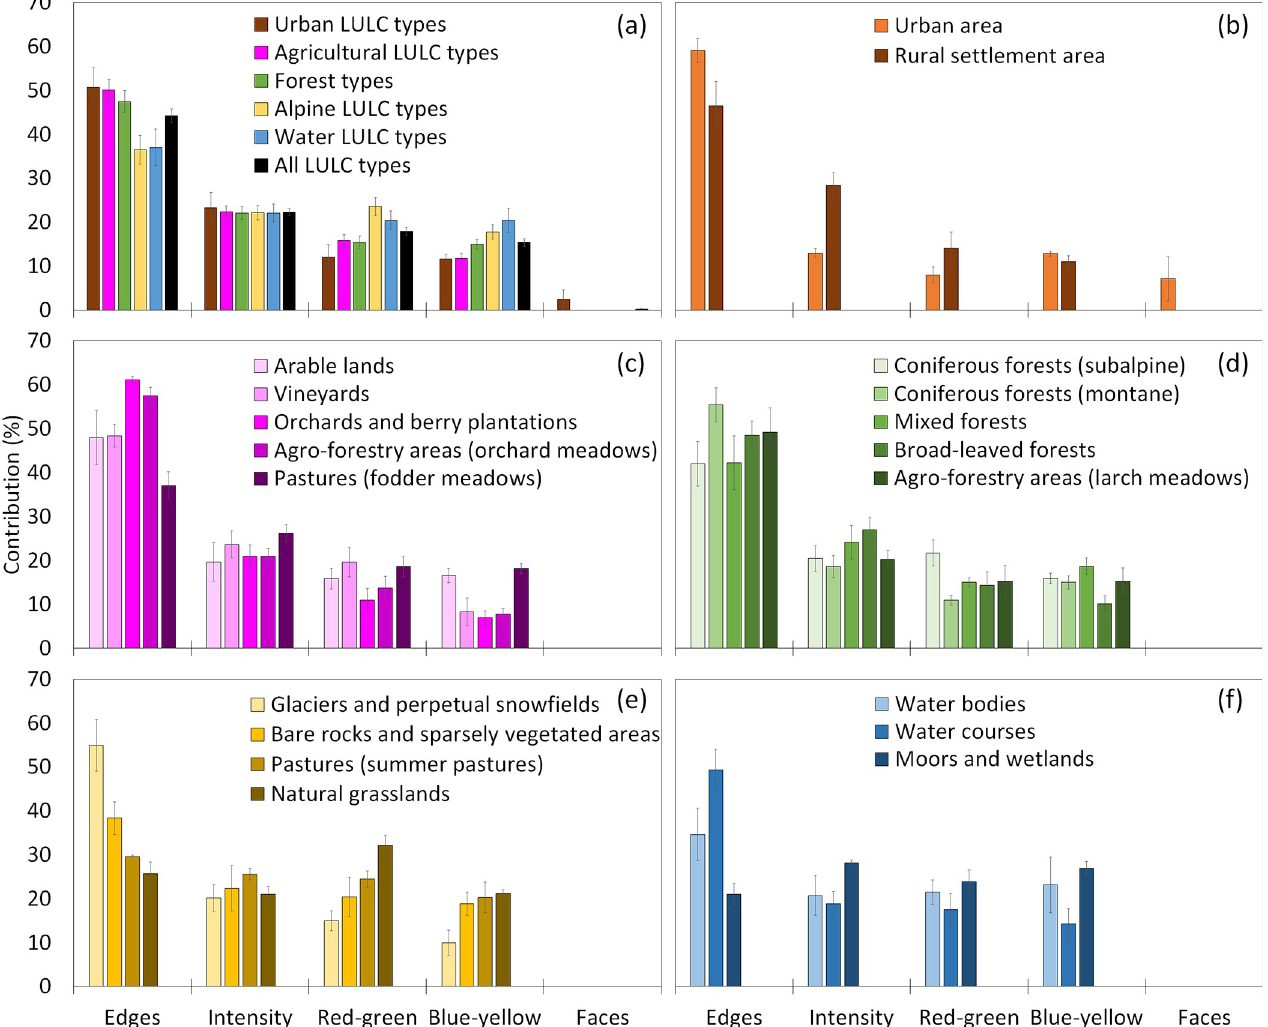
Fig 6. Contribution of visual elements (edges, intensity, red-green color contrast, blue-yellow color contrast, faces) to the probability that hotspot areas are seen within the first 3–5 seconds across all LULC types (a), urban LULC types (b), agricultural LULC types (c), forest types (d), alpine LULC types (e) and water LULC types